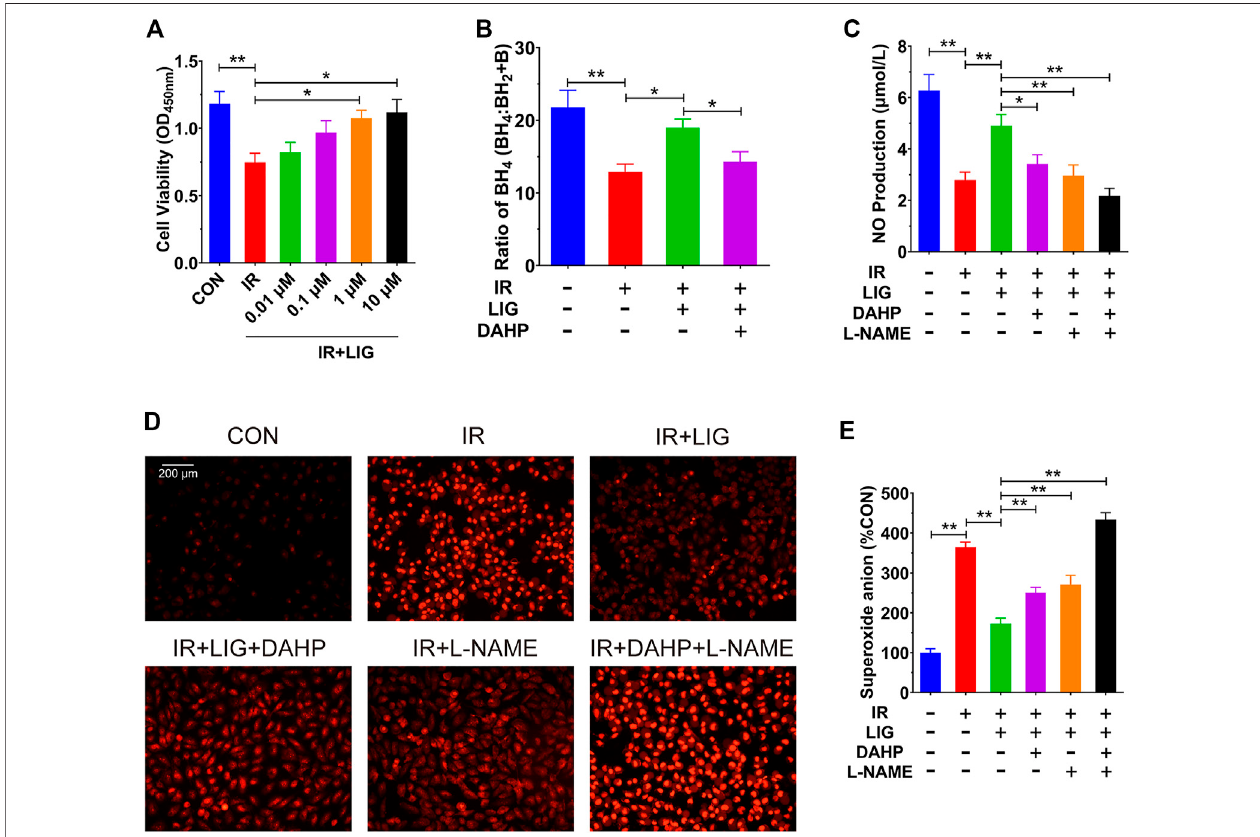
FIGURE4| LIGimprovedendothelialdysfunctioninIR-exposedHUVECs.HUVECswerepretreatedwithLIG(0.01 – 10.0 μ M),DAHP(10 mM)or L -NAME(100 μ M) for 12 hfollowed by10 Gyofirradiation. (A) Quanti fi cation ofHUVEC cellviabilityafterexposuretoIRwithor withoutLIG determined using aCCK-8kit. (B) RatioofBH4 to BH2+B in HUVECs. (C) The total amount of NO in HUVECs was determined by a total NO assay kit. (D) DHE fl uorescent probe labeling of superoxide anions in HUVECs. (E) Quanti fi cation of superoxide anions in HUVECs. The concentration of superoxide anions in HUVECs was analyzed using HPLC. DAHP, 2,4-diamino- 6-hydroxypyrimidine; L -NAME, N( ω )-nitro- L -arginine methyl ester. Data are the mean ± SEM, n (cid:1) 6. * p < 0.05; ** p <